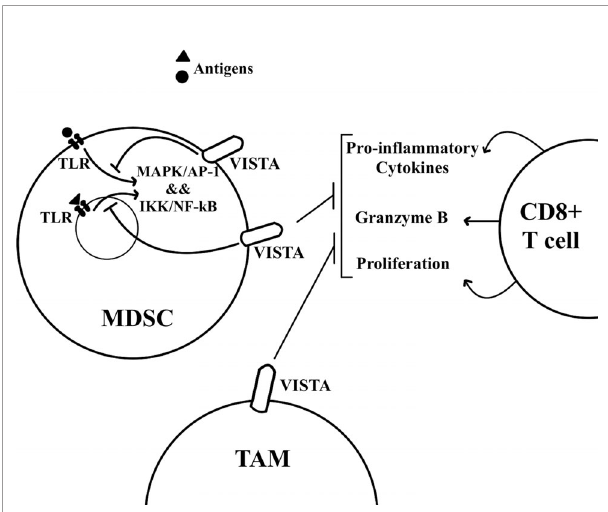
FIGURE 2 | VISTA is expressed by MDSCs and TAMs in the tumor microenvironment. T cells undergo immunosuppression in the tumor microenvironment. MDSCs and TAMs can inhibit T cell proliferation and effector functions such as the secretion of in fl ammatory cytokines. VISTA on MDSCs has been found to inhibit TLR mediated activation of MAPK/AP-1 and IKK/NF-kB signaling